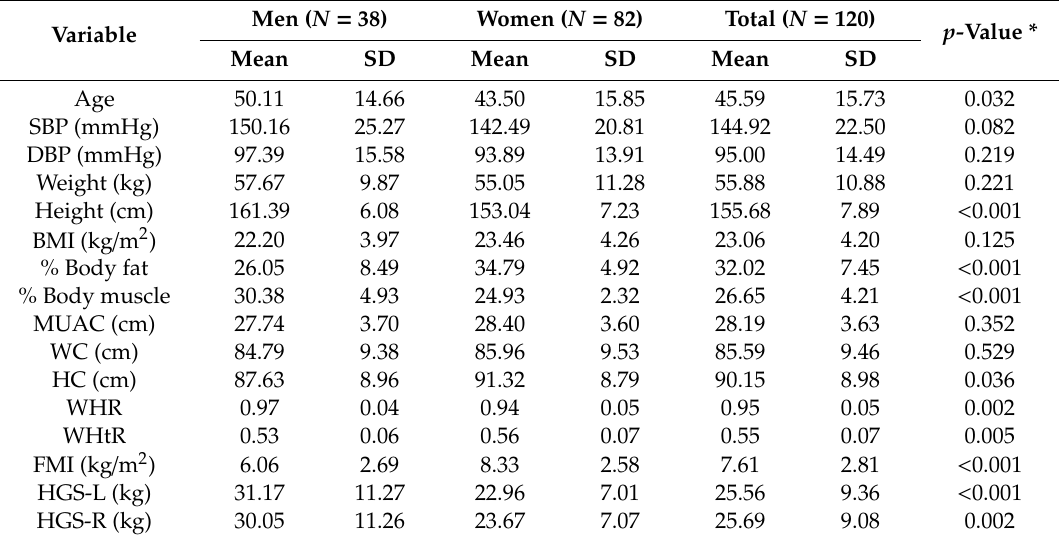
Table 2. Gender-specific anthropometric characteristics of the study